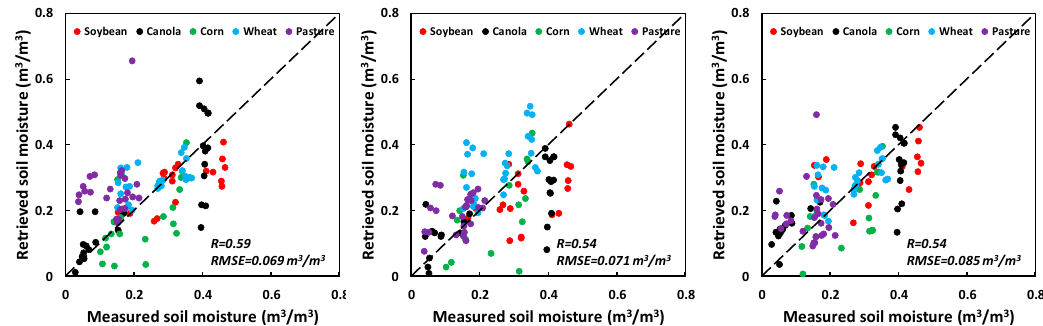
Figure 3. Plots of soil moisture measured from U.S. Department of Agriculture’s (USDA) stations and soil moisture retrieved from Radarsat-2 using ( a ) backscatters of HV polarization σ ◦ HV , ( b ) RVI, and ( c ) NDVI in the WCM for all crops.